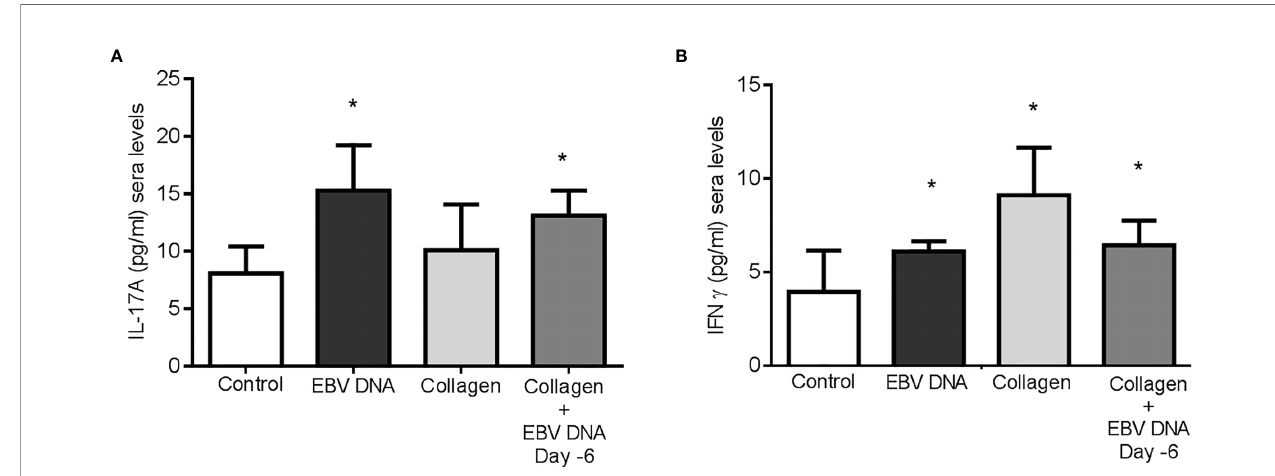
FIGURE 4 | Effect of EBV DNA on proin fl ammatory immune response in the collagen-induced arthritis mouse model. (A) Serum IL-17A levels in arthritic animals from C57BL/6J mouse groups treated with distilled water, EBV DNA only, type II chicken collagen or EBV DNA 6 days before collagen compared to control mice treated with distilled water. (B) Serum IFN ϒ levels in arthritic animals compared to control mice treated with distilled water. * indicates